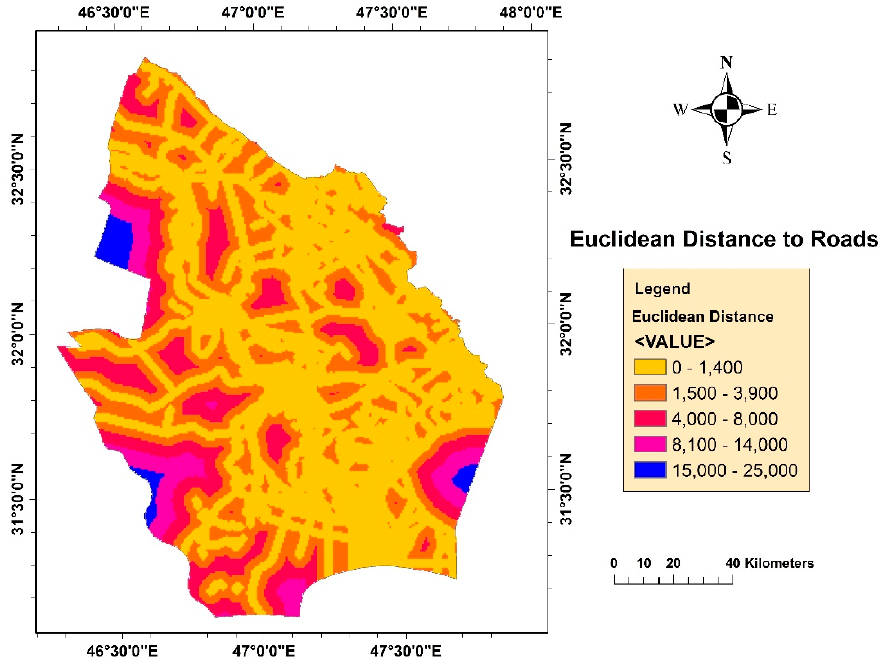
Figure 7. Normalized Difference Vegetation Index (NDVI) layer, based on Landsat 8 images.